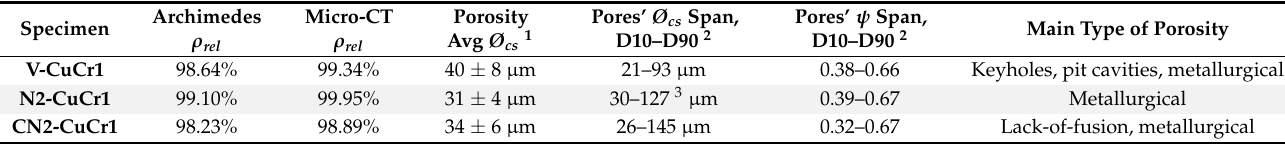
Table 1. Summary of the Archimedes and micro-CT porosity investigations of the three CuCr1 specimens, with relevant